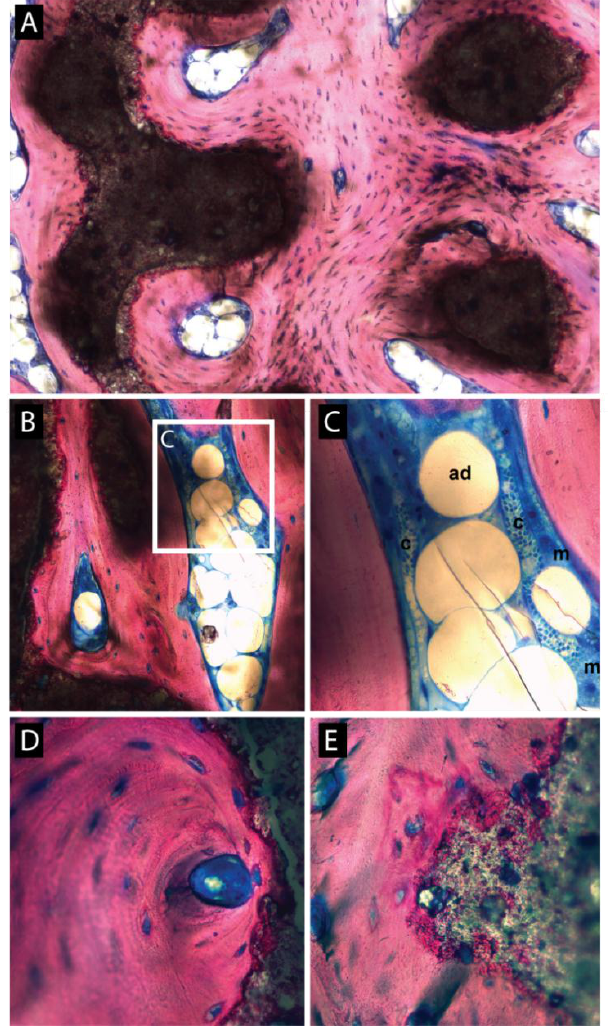
Figure 4. Higher magnifications showing mature bone at 16 weeks in BMP-2 primed constructs. ( A ) Presence of “haversian like” structures with adipocytic inclusions. Note the tight integration of the bone substitute remnants; ( B ) adipocytic inclusion within mature bone and higher magnification ( C ) showing adipocytes (ad), numerous capillaries (cp) and plump macrophages (m); ( D ) presence of newly formed osteons with central vasculature in close contact to the bone substitute that “dissolves” into the mature bone ( E ) in many